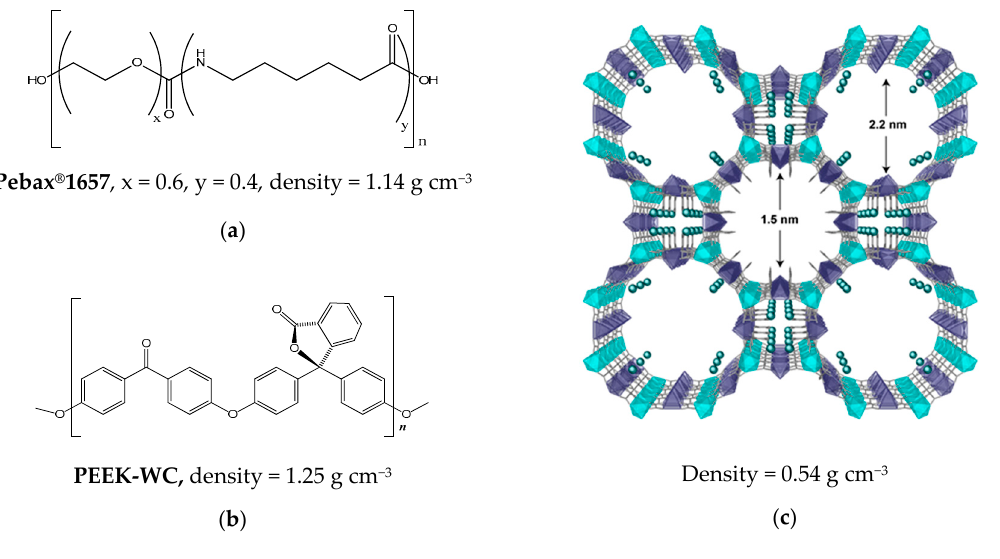
Figure 1. Chemical structure and density of ( a ) Pebax ® 1657, ( b ) PEEK-WC; and ( c ) CuNi-MOF. Cu and Ni atoms from the network are represented by cyan and green polyhedra, respectively, whereas organic ligands are depicted as sticks. Green spheres represent Ni 2+ metal ions in pores.